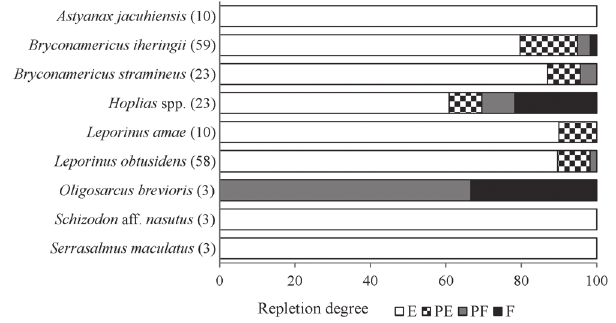
Fig. 4. Average repletion degree (%) of the captured larvae digestive tract from both environments of the Peixe River, from October 2011 to March 2012. Number of larvae examined is shown in brackets. Repletion degree: E - empty; PE - par- tially empty; PF - partially full; F - full.